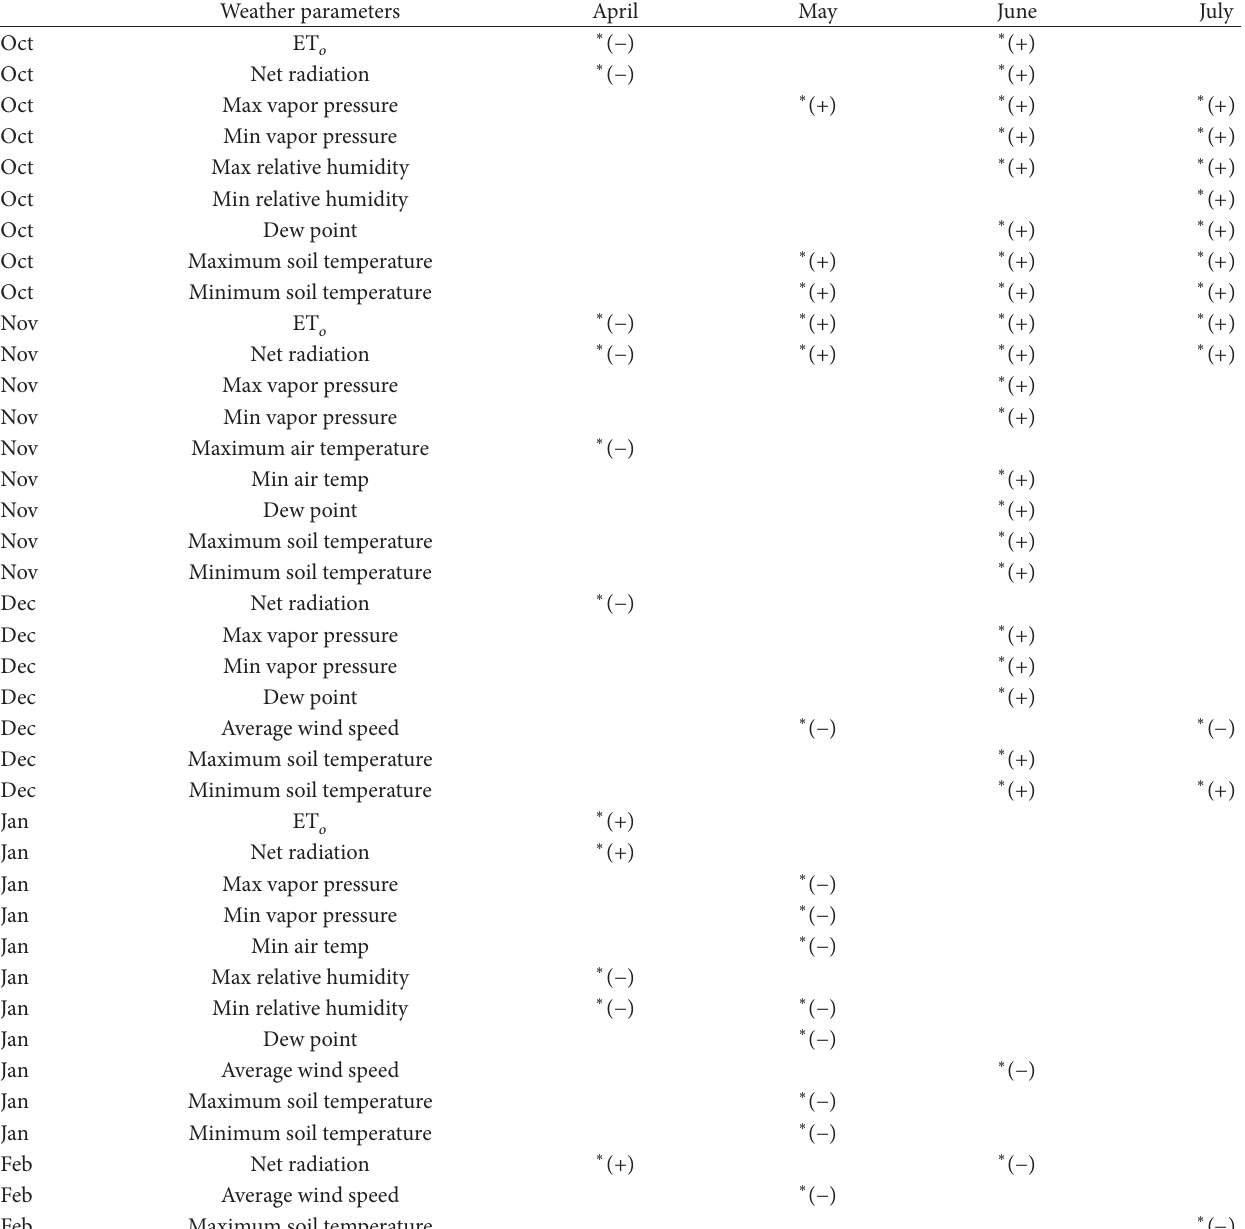
Table 1: Correlation matrix of monthly meteorological parameters (Oct–Feb) and strawberry yields